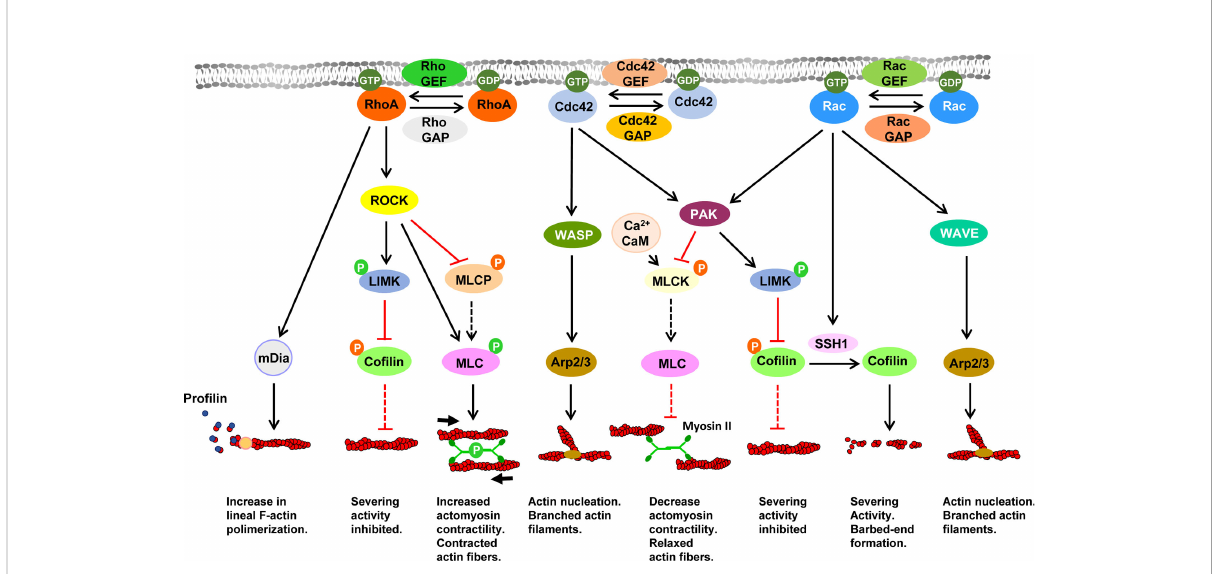
FIGURE 1 Signaling pathways controlling actin dynamics downstream of the Rho family of small GTPases Black and red lines indicate stimulatory and inhibitory effects, respectively. Dashed black or red lines indicate that upon inhibition of a speci fi c molecule, ceases the stimulatory or inhibitory effect exerted by this molecule on its direct downstream target. In the lower part of the fi gure is indicated the effect of the indicated pathway on F-actin. Abbreviations: Arp2/3, Actin Related Protein 2/3 complex; CaM, Calmodulin; Cdc42, Cell Division Cycle 42; GAP, GTPase-activating proteins; GDP, Guanosine diphosphate; GEF, Guanine nucleotide exchange factors; GTP, Guanosine-5 ’ -triphosphate; LIMK, LIM Motif- Containing Protein Kinase; mDia, mammalian Diaphanous-related formin; MLC, myosin light chain; MLCK, myosin light-chain kinase; MLCP, Myosin Light-Chain Phosphatase; PAK, p21-activated kinase; Rac, Ras-Related C3 Botulinum Toxin Substrate; RhoA, Ras homolog family member A; ROCK, Rho-associated protein kinase; SSH1, slingshot protein phosphatase 1; WASP, Wiskott-Aldrich Syndrome protein; WAVE, WASP-family verprolin-homologous